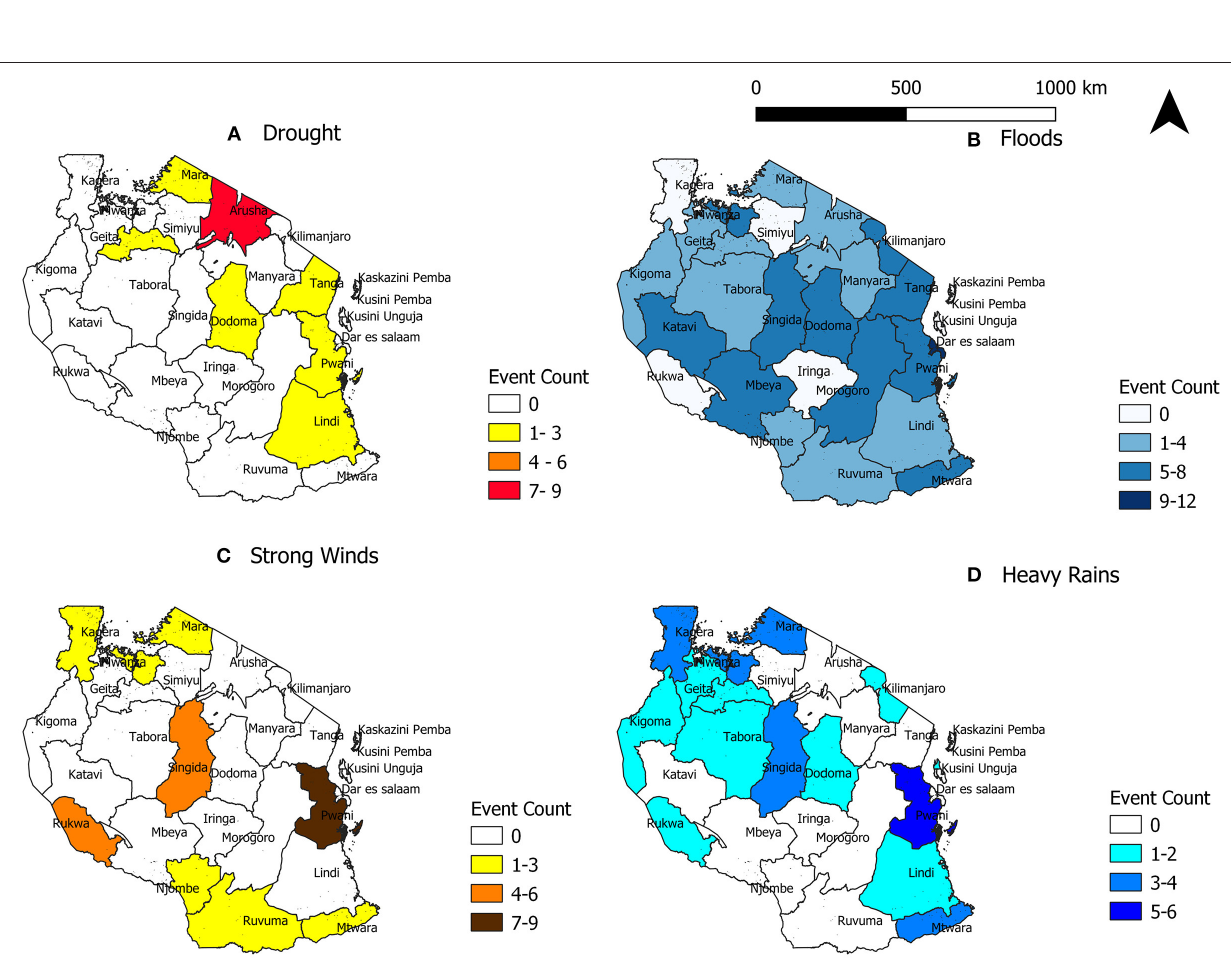
Frontiers in Climate |